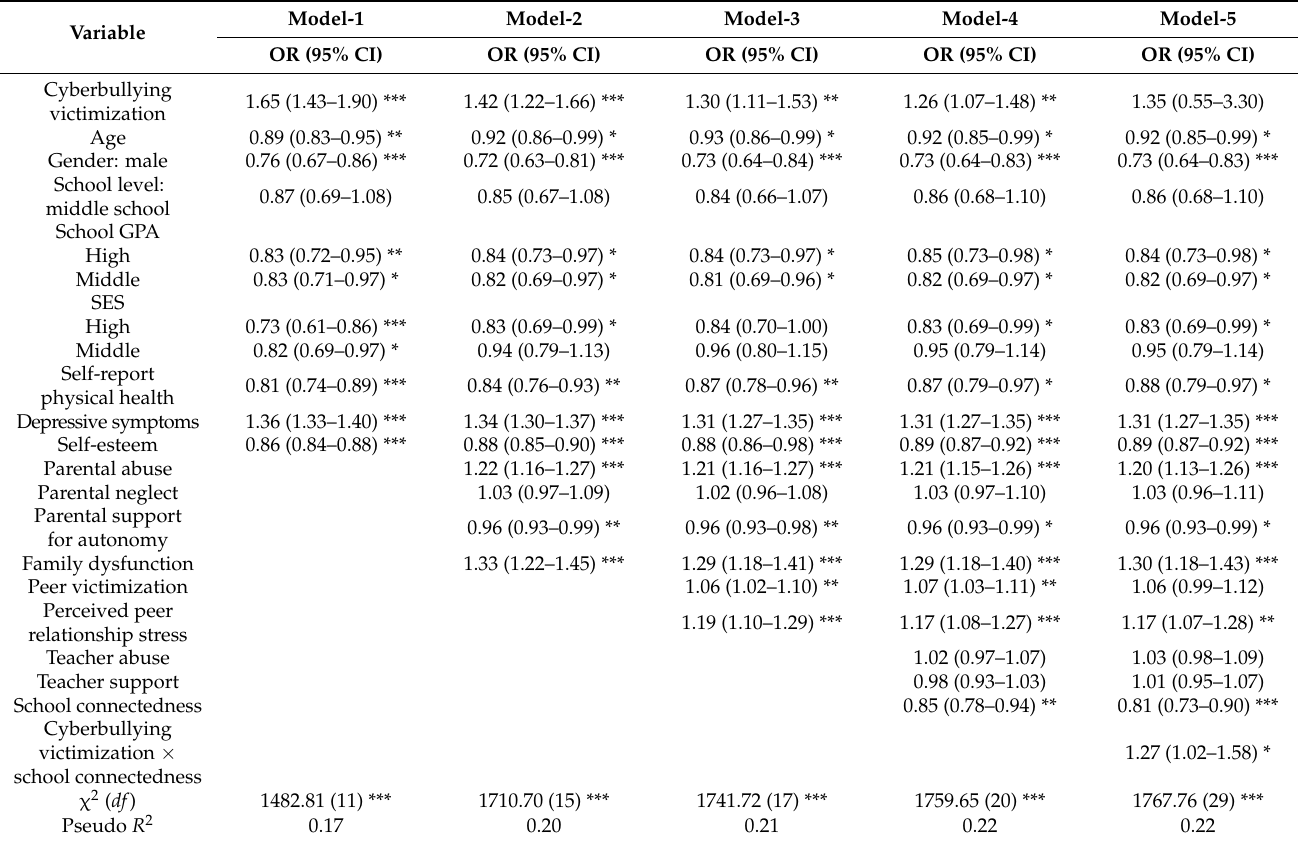
Table 3. Logistic regressions that predicted suicidal ideation by cyberbullying victimization and social-ecological